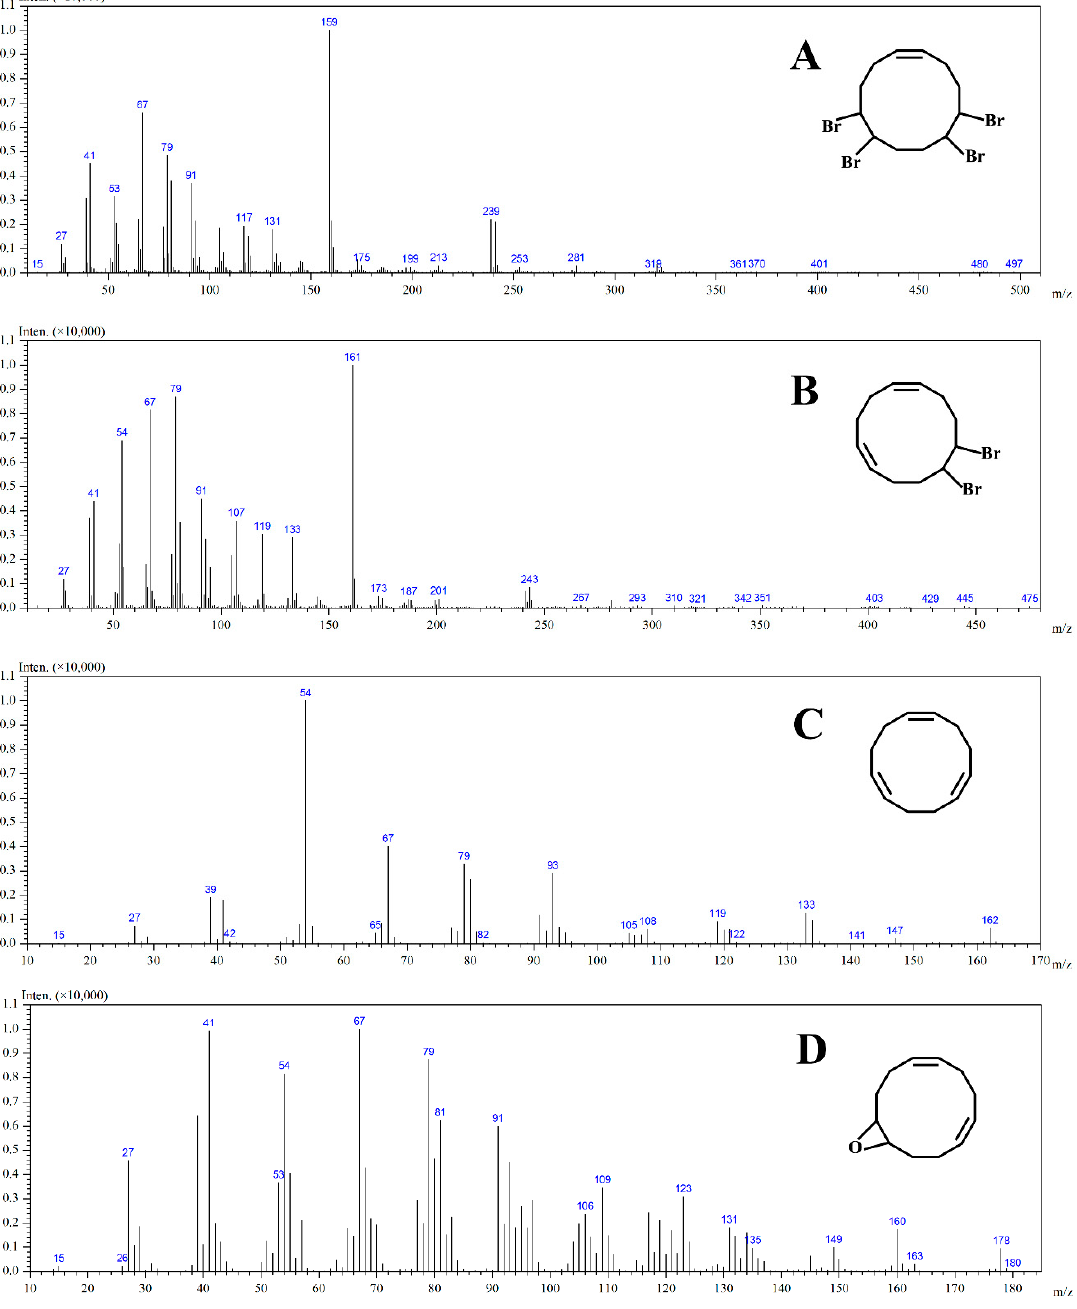
Figure 6. The mass spectrum of the intermediates in the UV/TiO 2 /KPS system at 90 min (( A ) Tetrabromocyclododecene; ( B ) Dibromocyclododecadiene; ( C ) 1,5,9-Cyclododecatriene; ( D ) 1,2-Epoxy-5,9-cyclododecadiene; ( E ) Dibromo-epoxy-cyclododecene; ( F ) 4,5-dibromooctanedioic acid; ( G ) succinic acid). By analyzing the degradation products of GC/MS, the possible degradation pathway of HBCD in UV/TiO 2 /KPS system is determined, as shown in Figure 7. Under the action of active free radicals, two adjacent C–Br bonds in the molecular structure of HBCD undergo cleavage and debromination to form carbon-carbon double bonds, thus the compounds A, B, and C were obtained successively [34]. Compound C can be directly oxidized to D or oxidized to G by double bond cleavage. In addition, the compound B can also be oxidized to form the compound E, or oxidized to F and G by double bond cleavage [35]. The compound F can also be further